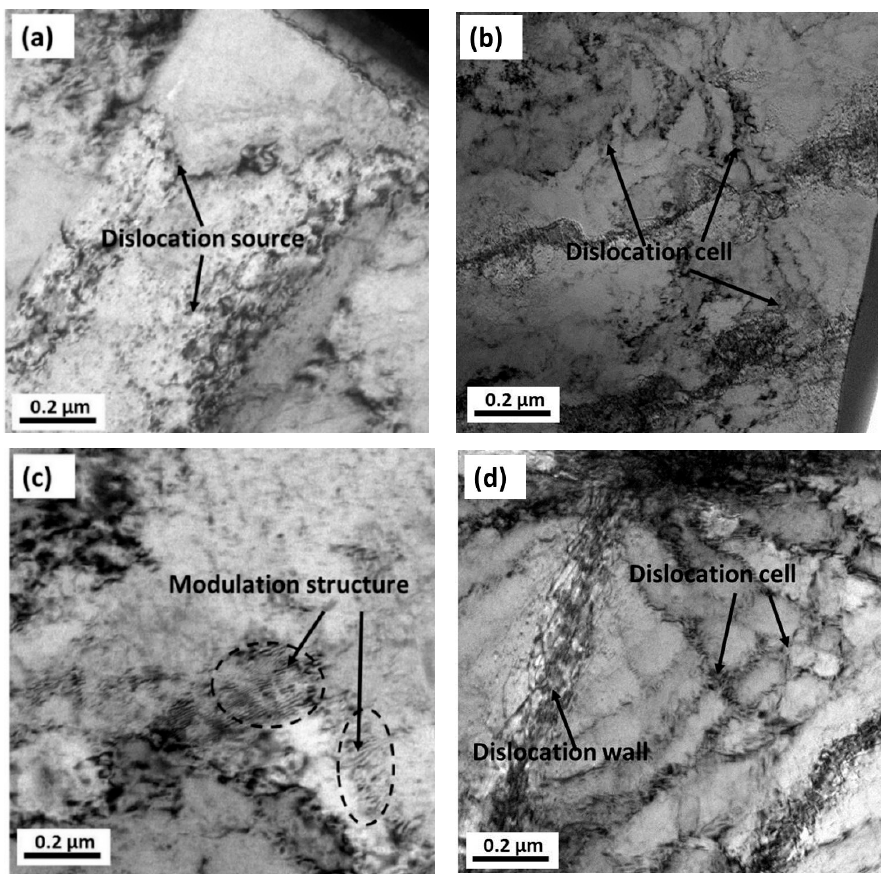
Figure 12. TEM bright field images of different regions of the rolled Cu strips: ( a ) uncorroded site of 20.7% reduced strip, ( b ) near-pit site of 20.7% reduced strip, and ( c ) uncorroded site of the 77.3% reduced strip, ( d ) near-pit site of 77.3% reduced strip.